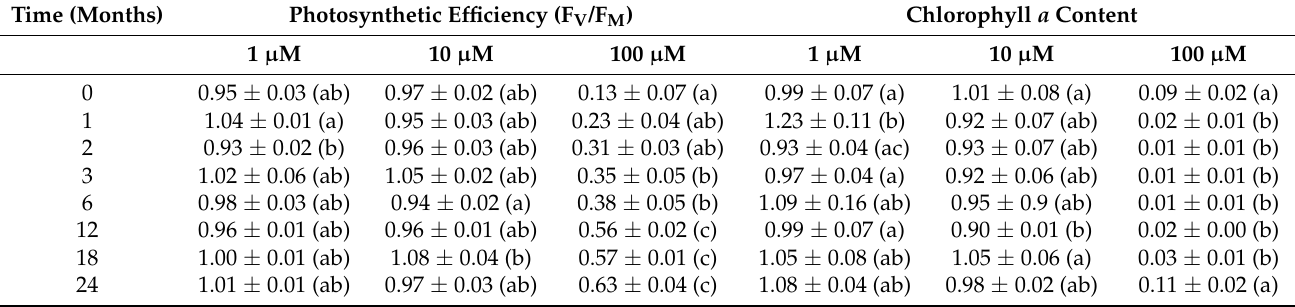
Table 1. Photosynthetic efficiency (F V /F M ) and chlorophyll a content (ratio of treated to control values) in samples of the lichen Evernia prunastri incubated with 1, 10, and 100 µ M Hg 2+ solutions and transplanted for 1, 2, 3, 6, 12, 18, and 24 months at the Botanical Garden of the University of Siena. Different letters indicate statistically significant ( p < 0.05) differences between ratios over time.